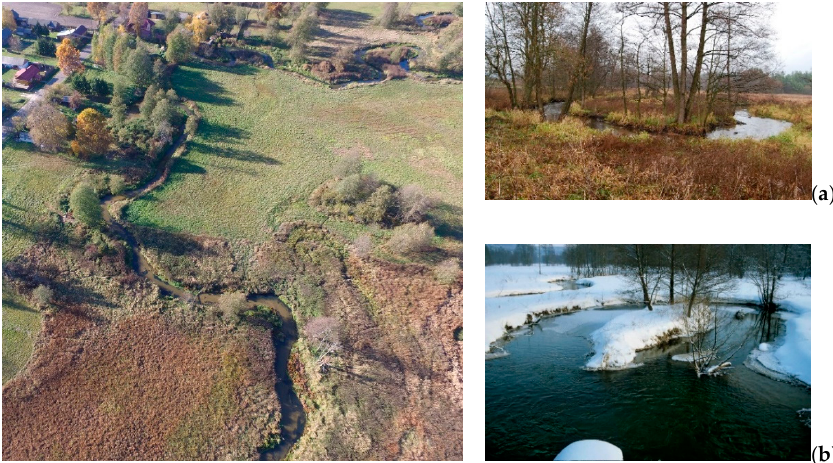
Figure 6. The riverbed of the Wieprz valley near Guciów: ( a ) large-radius meander in spring, ( b ) large-radius meander in winter.